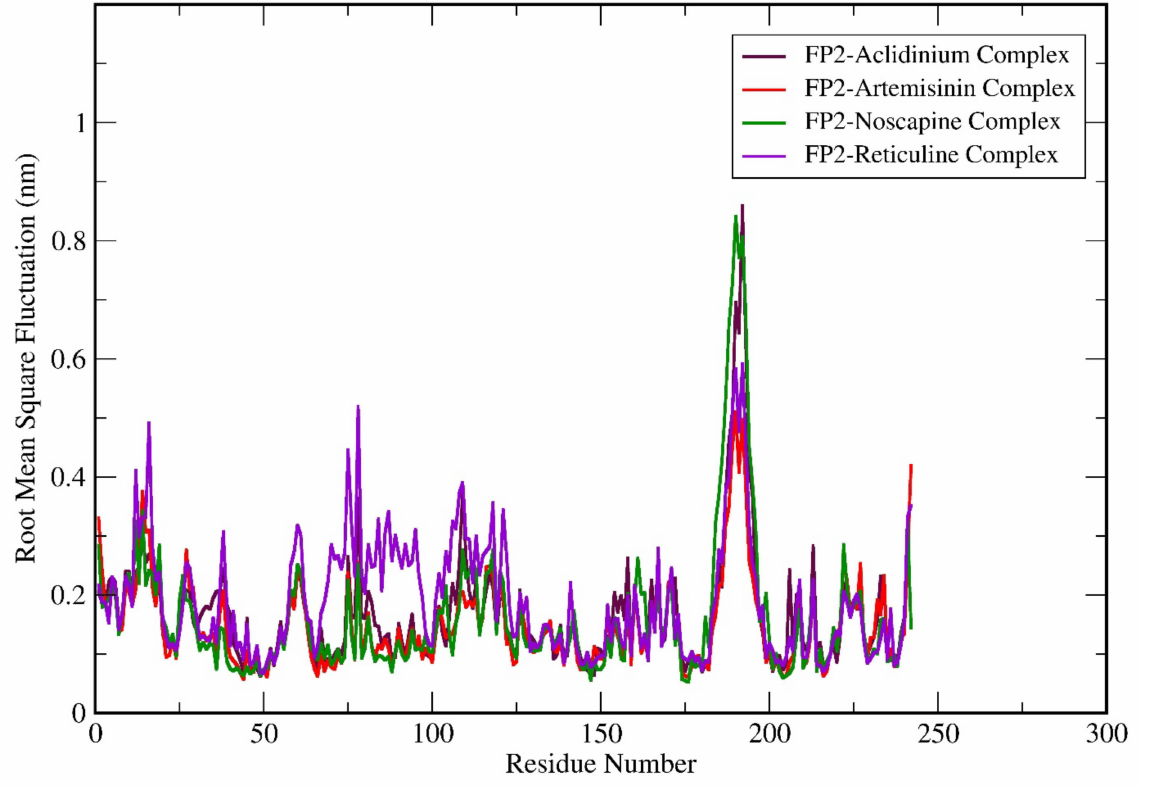
Figure 5. Molecular dynamics simulation (MDS) result analysis for FP-2-Artemisinin, FP-2 Noscapine, FP-2 Reticuline, and FP-2 Aclidinium complexes representing RMSF (Root mean square